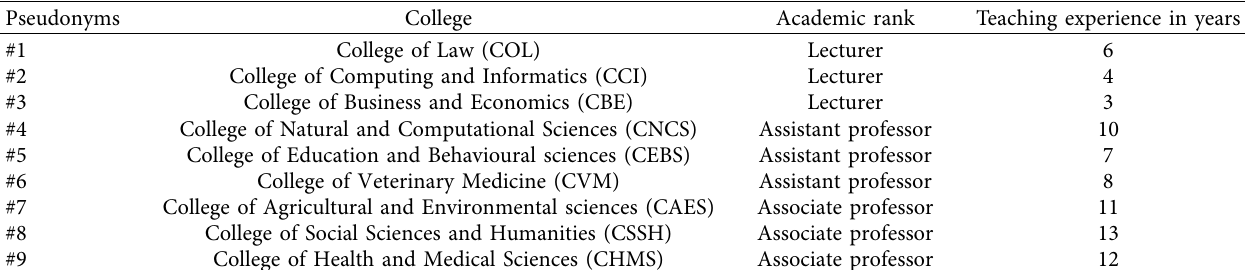
Table 3: Profile of the